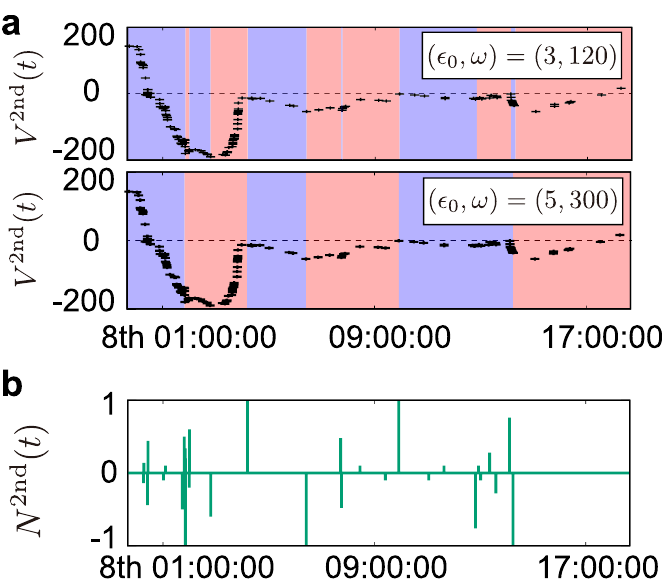
Fig 3. Example of the generation process of the outlier signals N 2nd ( t ) for the second top bank. (a) The position trajectory of the second top bank from 00:00 to 18:00 on 8 June 2016 is shown by the black points. The top (bottom) translucent red and blue boxes represent the drawups and drawdowns, respectively, obtained by the epsilon drawdown (EDD) method (see text) using parameter ( � 0 , ω ) = (3,120), and (5,300). (b) Aggregation over a set of parameters ( � 0 , ω ) (see text) of the end points of drawups and drawdowns detected by the EDD method for this second top bank, given by Eqs (9), and (11).